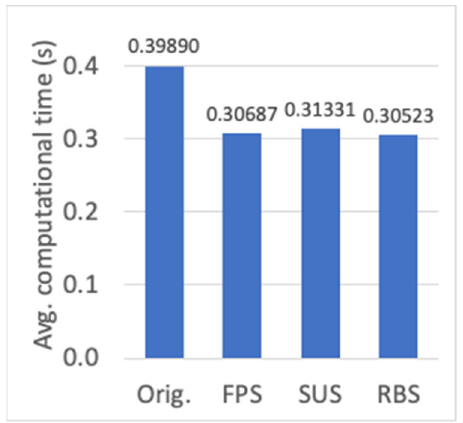
Figure 12. Average computational time (s) for different parent selection algorithms.